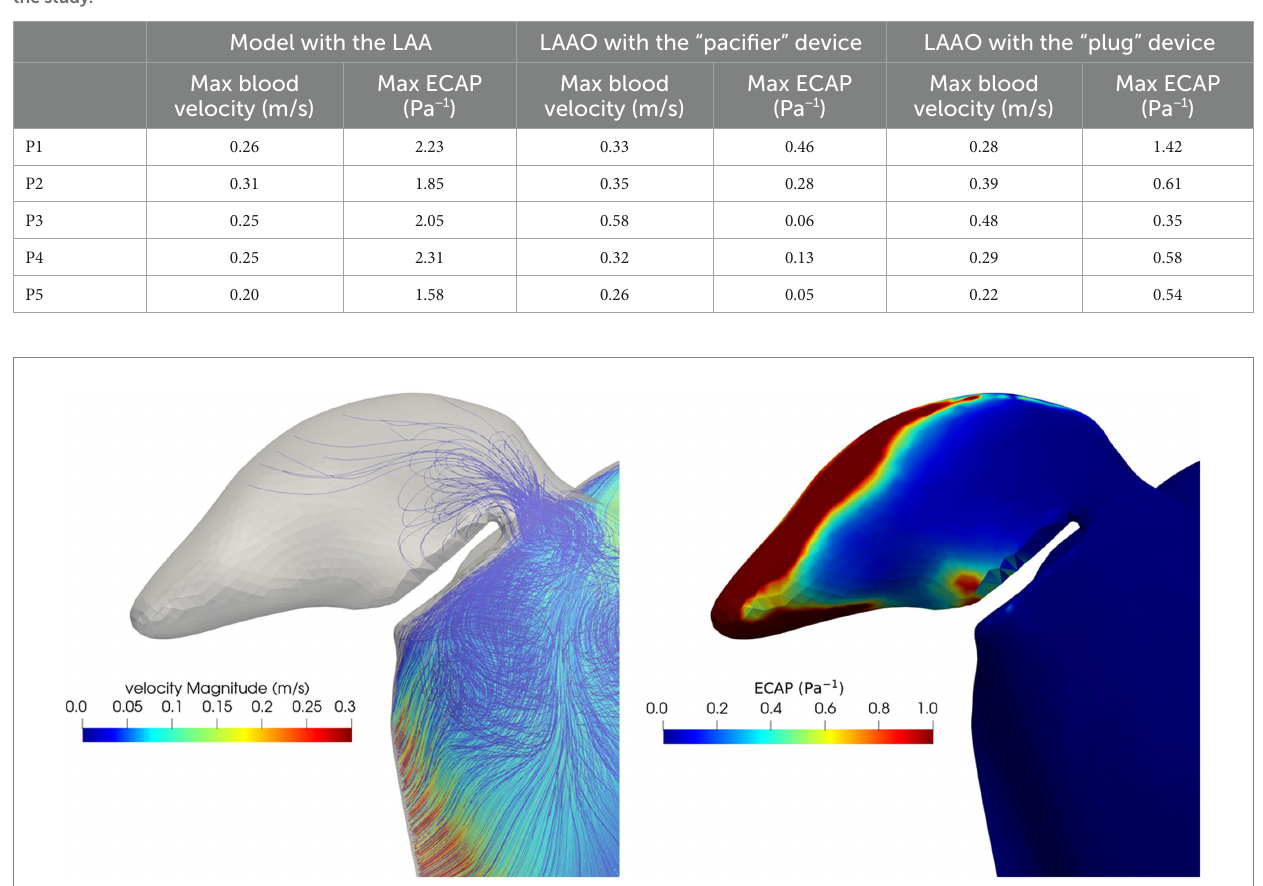
FIGURE 7 Blood velocity streamlines (left) and ECAP map (right) in the LAA and in the volume close to the occluders in the peri-device leak